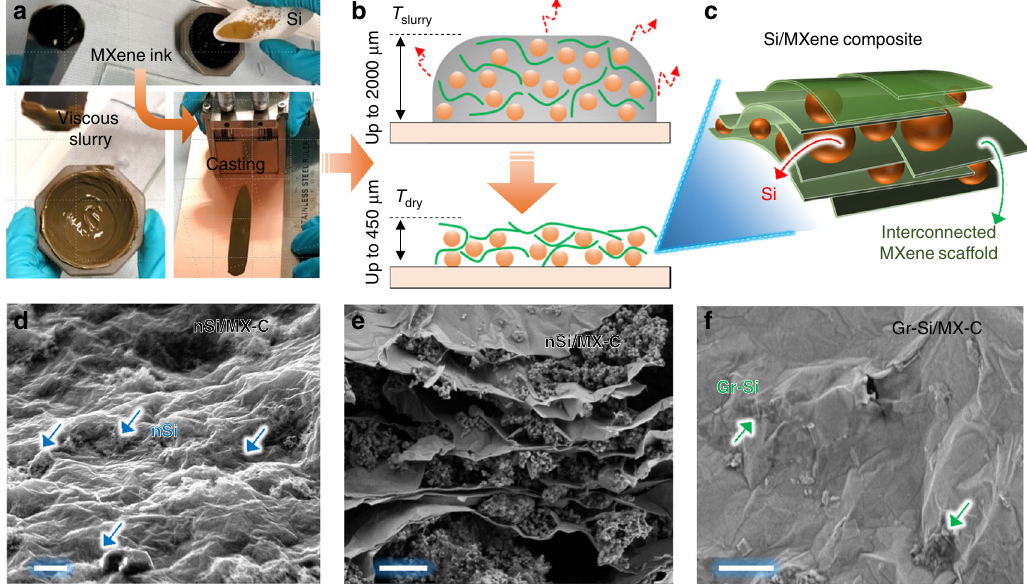
Fig. 2 Fabrication of composite electrodes. a Composite electrode preparation from Si/MXene ink-based slurry. b The slurry drying process and c scheme displaying the resulting Si/MXene composite. The MXene nanosheets form a continuous scaffold and enable the formation of a thick electrode. d Top-view and e cross-sectional scanning electron microscopy (SEM) images of nSi/MX-C electrode, showing the Si nanoparticles are well wrapped by the MX-C nanosheets in a manner of sandwiching (scale bar for d and e = 1 µ m). f Top-view SEM image of Gr-Si/MX-C electrode, indicating that the Gr-Si particles are well wrapped by the continuous MX-C network (scale bar = 1 µ m)